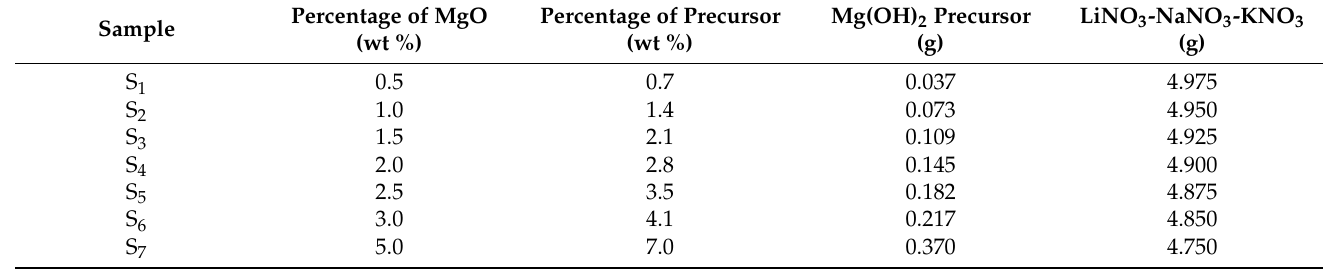
Table 1. The content of each ingredient in the preparation.